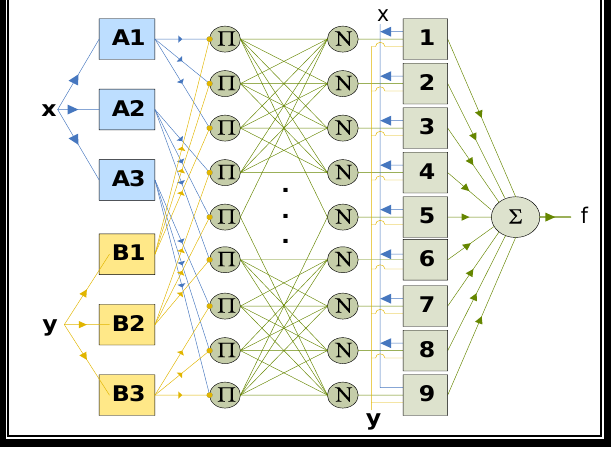
Fig. 4 . Framework of MISO ANFIS